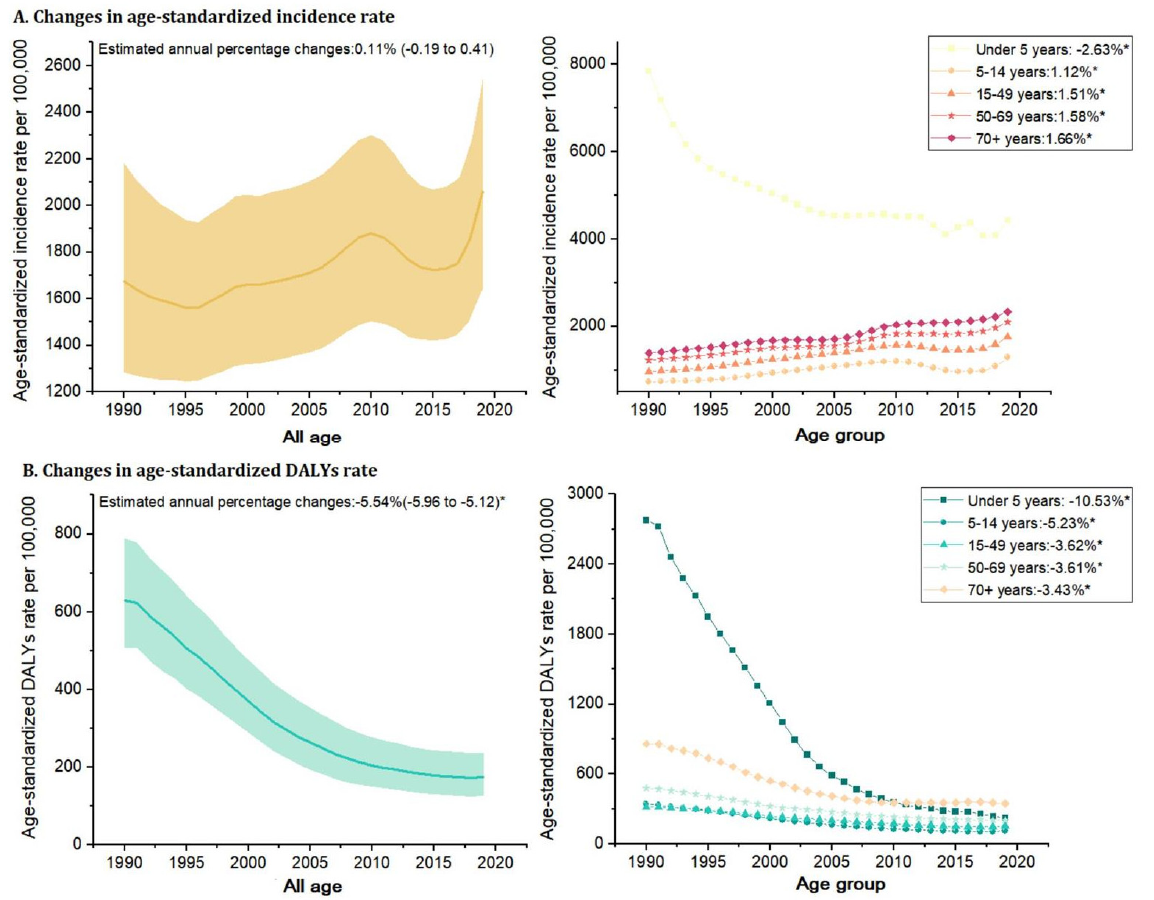
Figure 2. Change in the age-standardized incidence rate and DALYs rate of nutritional deficiencies from 1990 to 2019 in China. ( A ) Age-standardized incidence rate; ( B ) Age-standardized DALYs rate. DALYs = disability-adjusted life-years. Note: (*) Indicates statistically significant trend ( p <